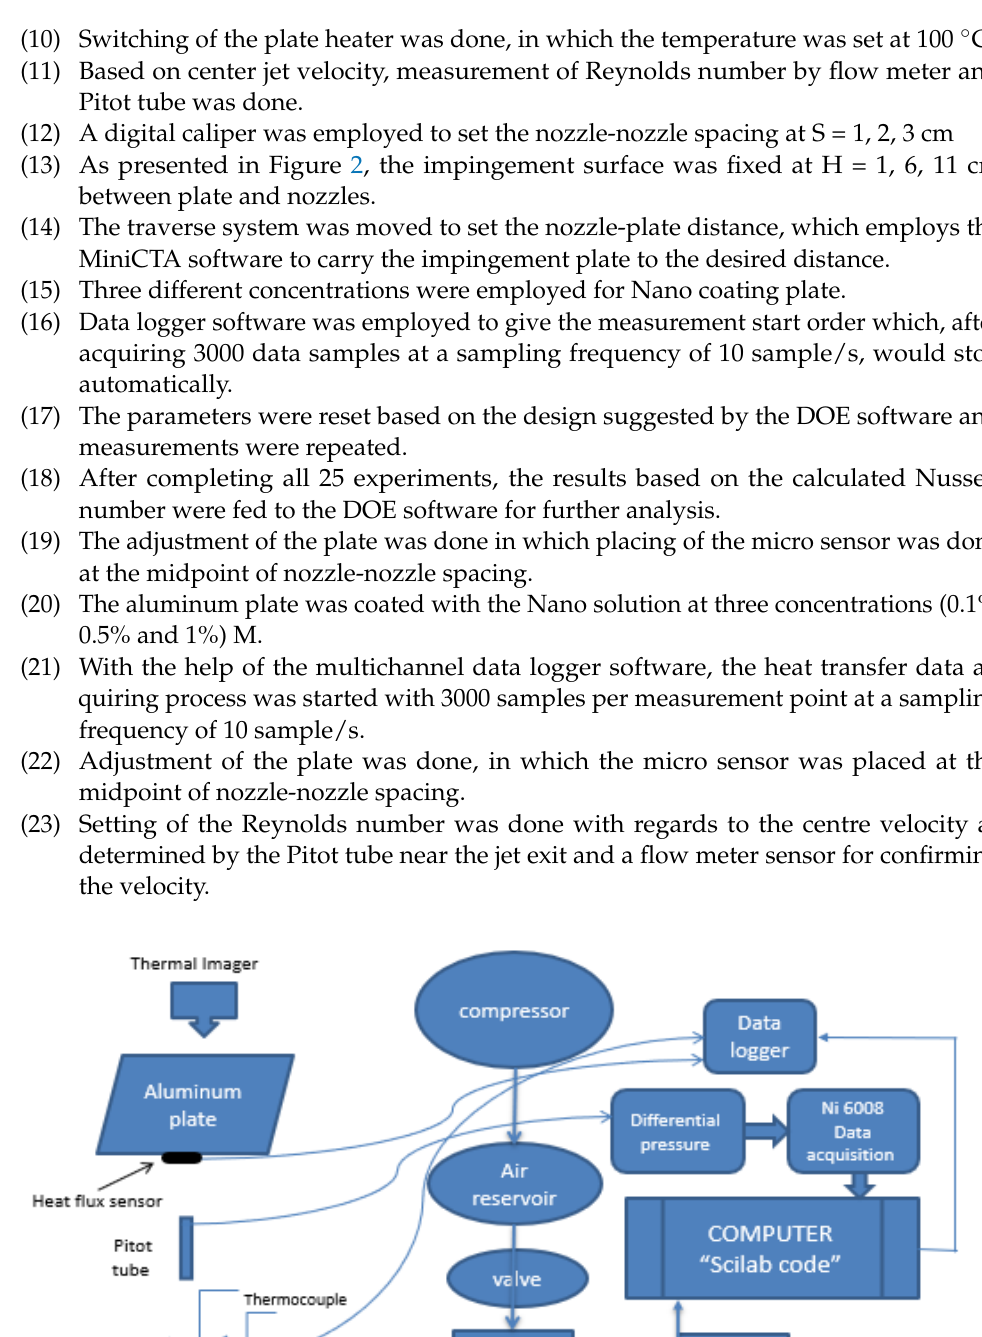
Figure 2. A typical procedure of the method in the preparation of Nano solution and experimental procedures.